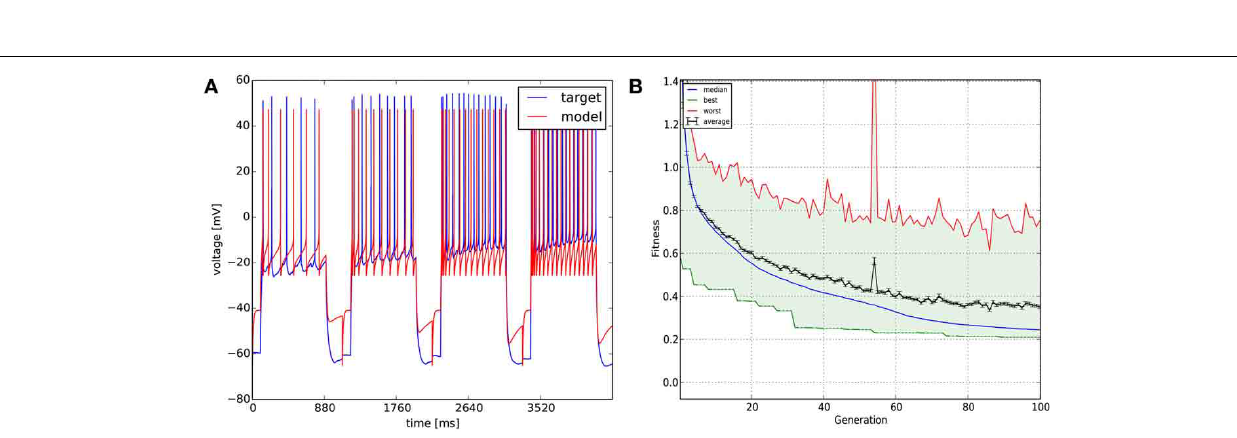
FIGURE 8 | The results of Optimizer on Use case 5 (fitting an adaptive exponential integrate-and-fire model to experimental data with multiple traces). The four traces are displayed in concatenated form in the figure. Figure layout and notation are similar to Figures 4 , 5